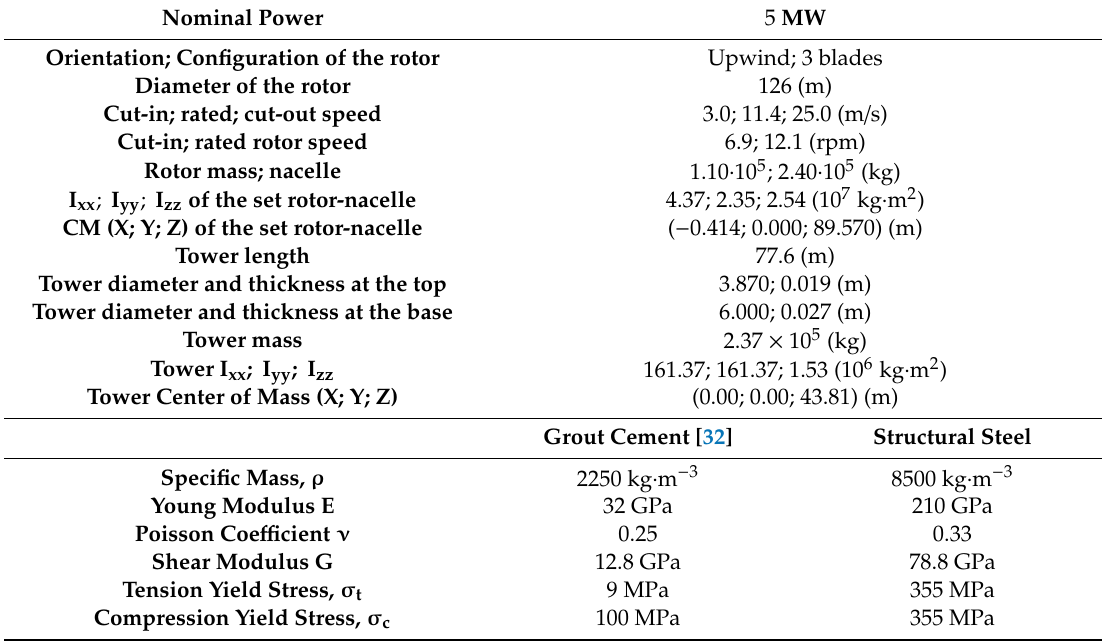
Table 1. Properties of the turbine equipment and supporting structures.